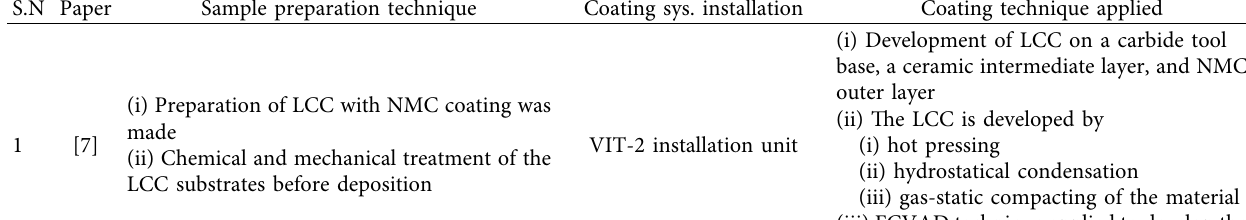
Table 1: Synthesis of the coating techniques